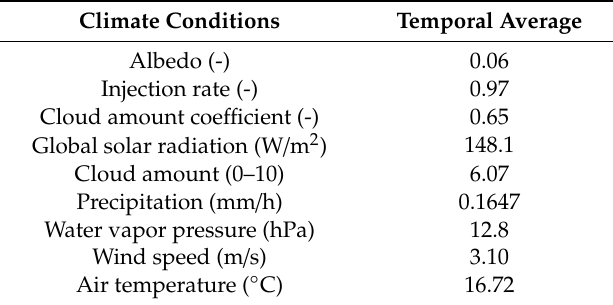
Table 3. Climate Table 3. Climate conditions.